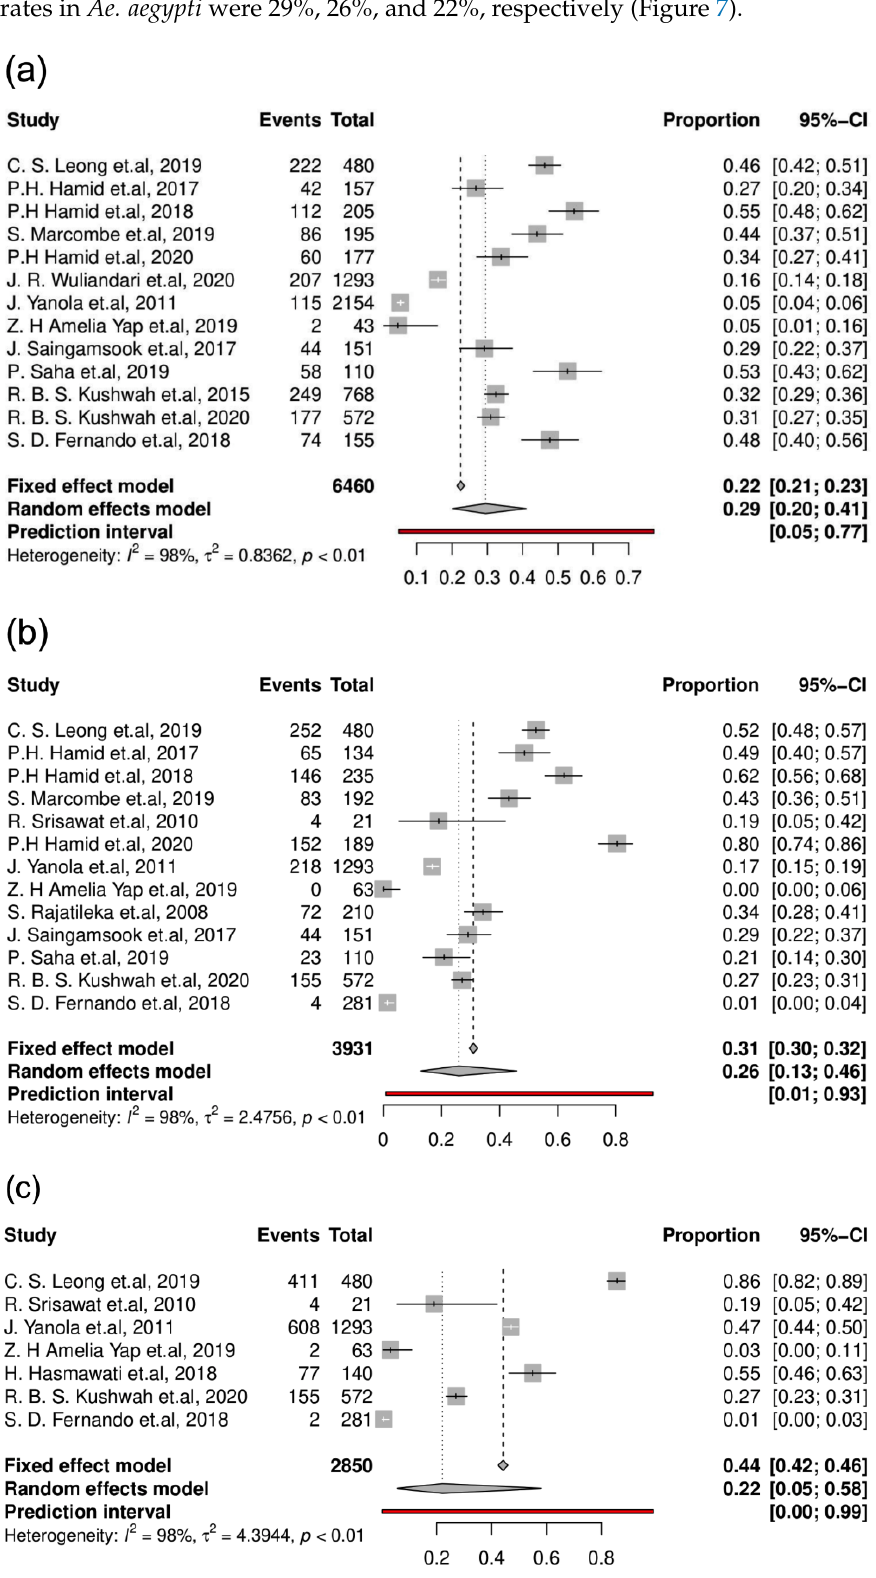
Figure 6. ( a ) Meta-analysis results of the summarized insecticide resistance rates. ( b ) Subgroup meta-analysis of insecticide resistance rates for the two time periods.